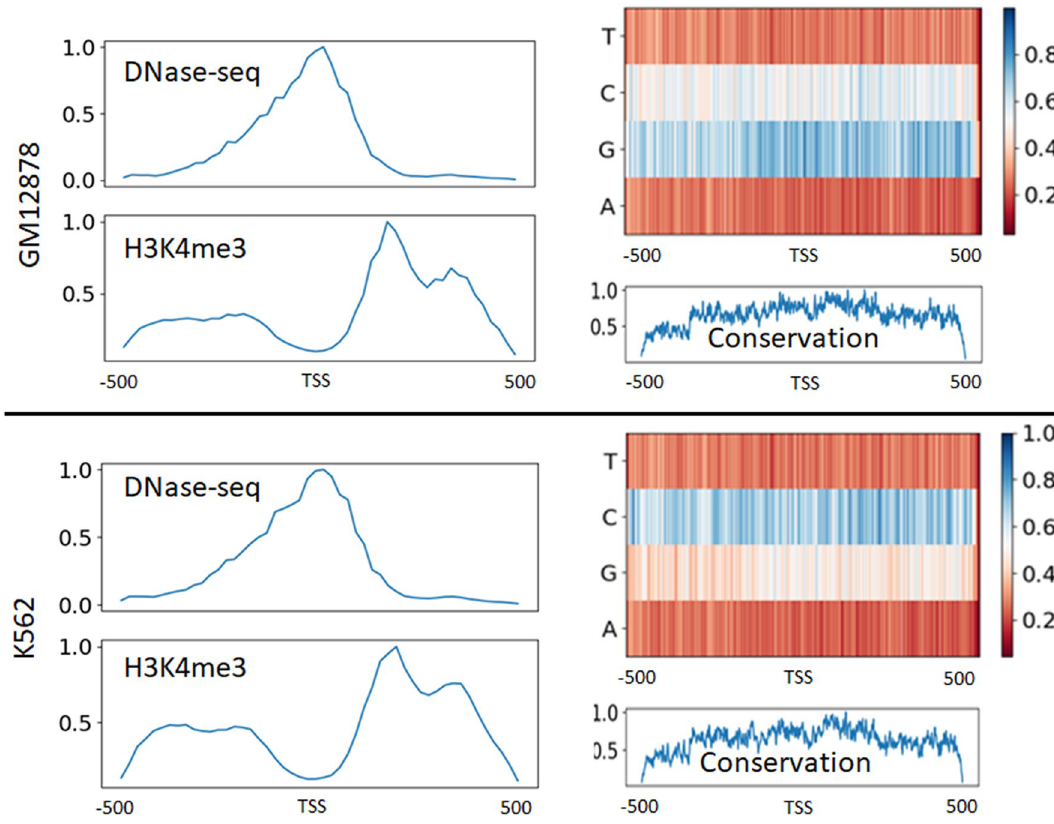
Figure 4. Average activation of CNN Block 4 in terms of the change of the DNase-seq, H3K4me3, sequence (A, G, C, T) and conservation values in different locations within 1 kbp around the D-miRT predicted TSSs. The activations are shown for GM12878 and K562. The heatmap was created using python V3.7 (https ://www.pytho n.org/).